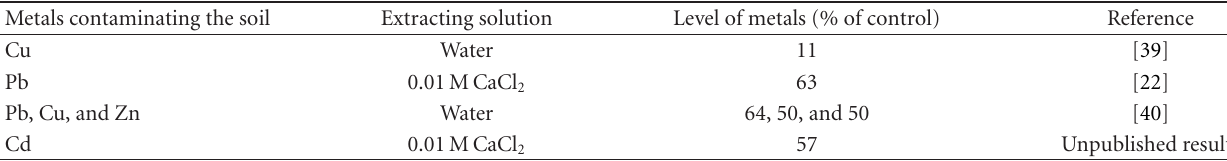
Table 2: Extractable levels of metals in contaminated soils.